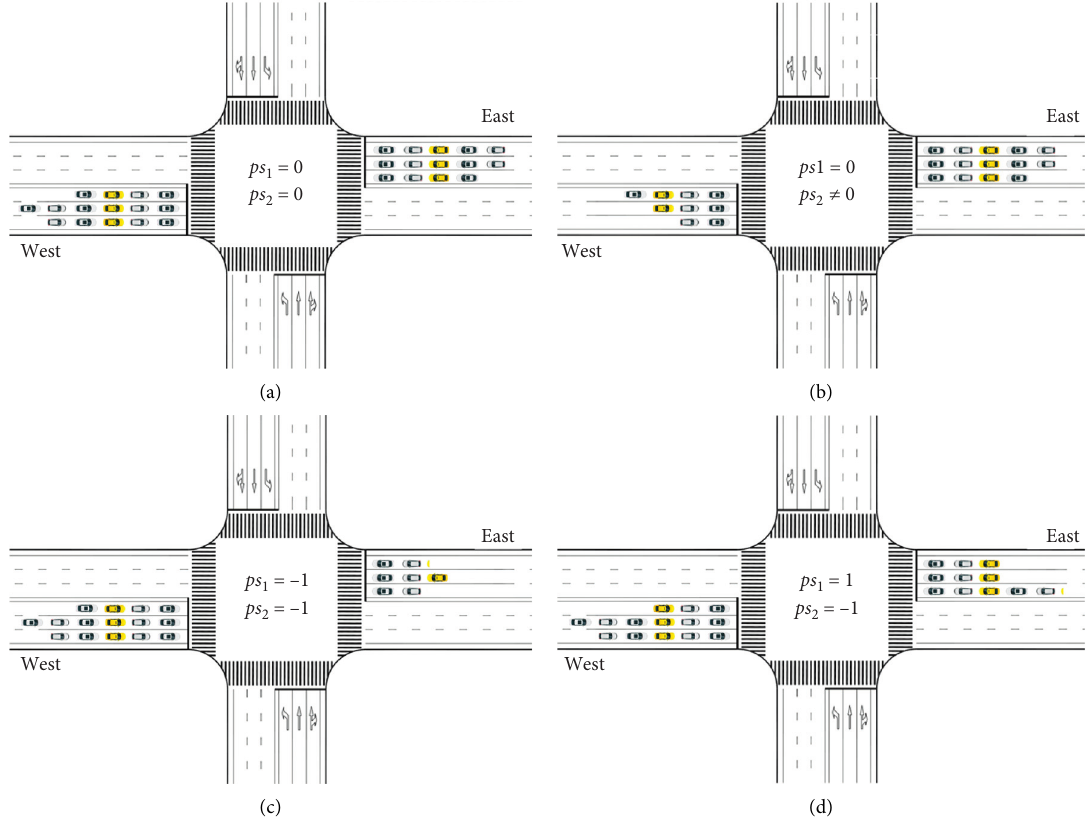
Figure 3: Possible states of opposite traffic flow in the east and west approaches when ac symmetrical.(b)Left-turntrafficflowisasymmetricalandthroughtrafficflowissymmetrical,orviceversa.(c)Left-turntrafficflowisasymmetrical in the same direction to through traffic flow. (d) Left-turn traffic flow is asymmetrical in the opposite direction to through traffic flow.